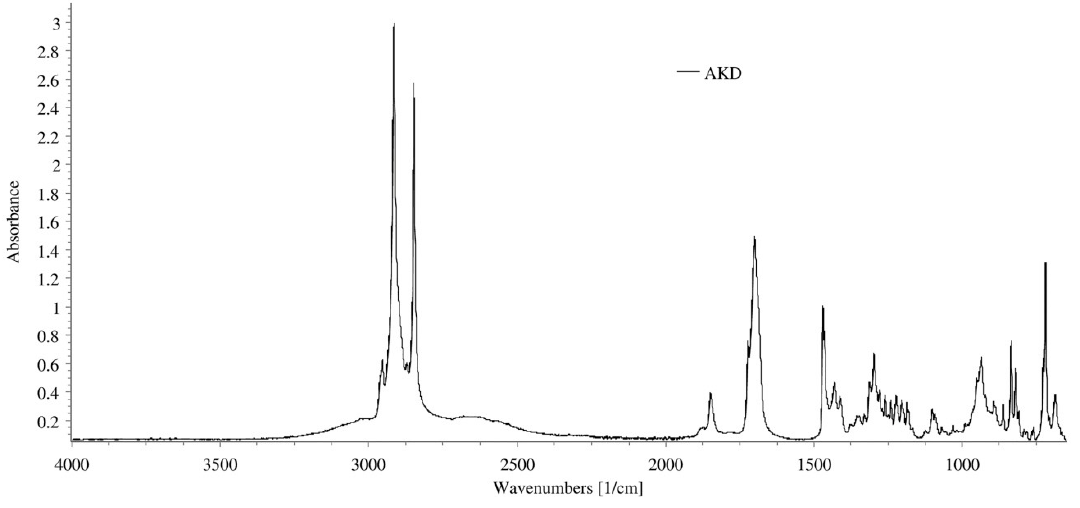
Figure 5. FTIR spectra of alkyl ketene dimer (AKD).